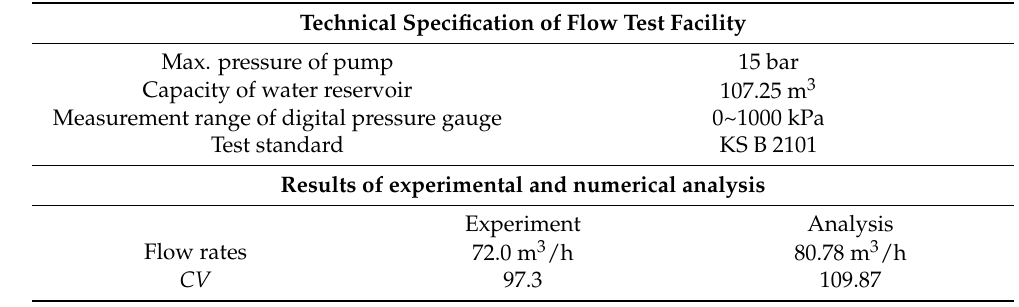
Figure 8. Experimental equipment and test set-up for CV measurement. Table 2. Technical specifications of flow test facility and results of experimental and numerical analysis for the fully opened proposed cylinder-in-ball valve.